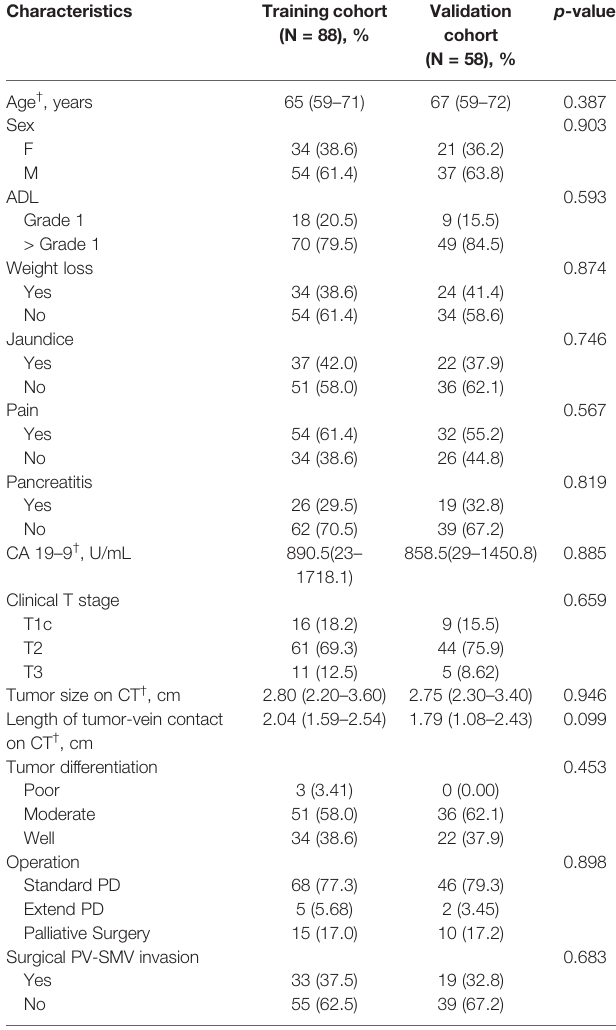
TABLE 1 | Patient characteristics.